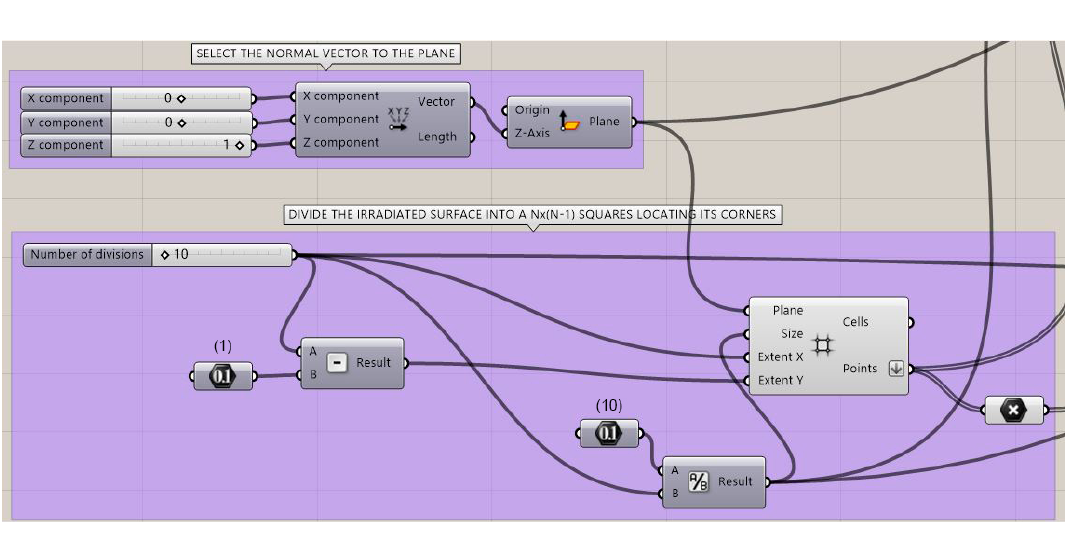
Figure 7. First part of the algorithm.